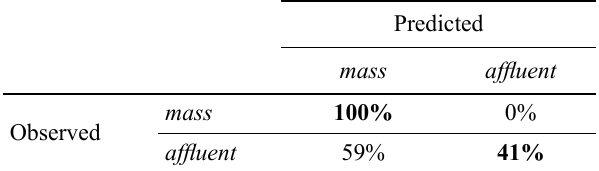
Table 3. Confusion matrix for Test sample using MLP